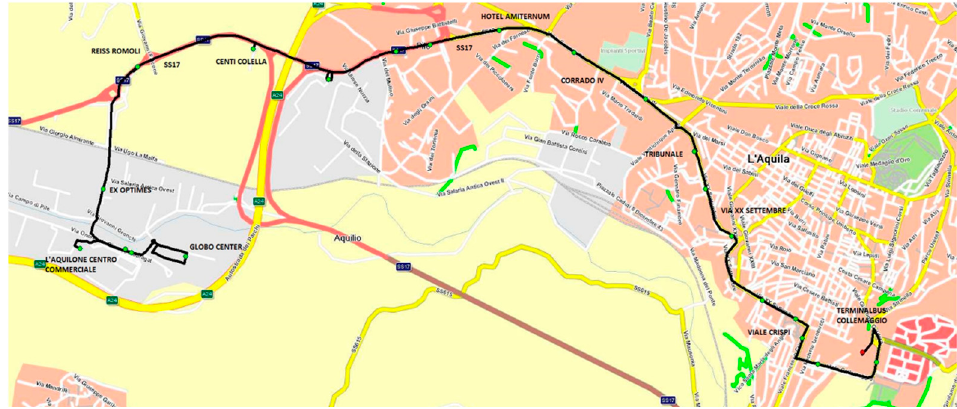
Figure 4. Line 2 of the L’Aquila transport network (black line). Source: Azienda Mobilita Aquilana (AMA) (L’Aquila public transport company).